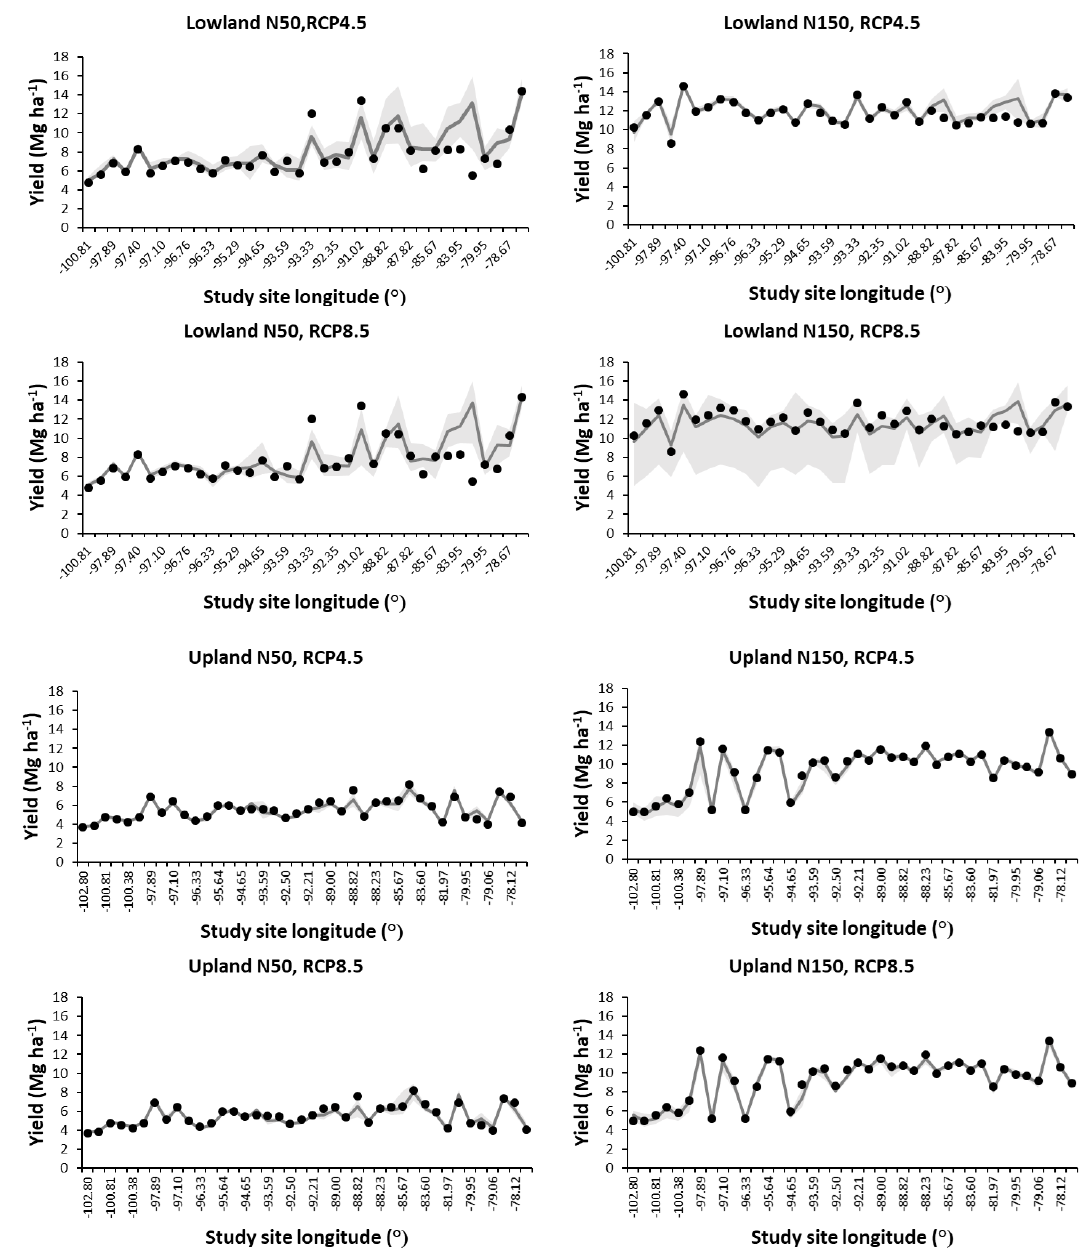
Figure 6. Impact of climate change on yields of switchgrass lowland and upland cultivars in two different nitrogen (N) fertilizer treatments, N50 and N150 kg ha −1 . The switchgrass simulation yields in the future period (2021−2050) across study areas for each nitrogen treatment within each ecotype and within each RCP pathway were compared with the reference period (1976−2005) period. Grey shade areas indicate the range of simulation yields in future period based on running eight global circulation models (GCMs). The dark grey line showed average simulation yields in the future period based on running eight GCMs. Black circle indicates simulation yields in reference period.